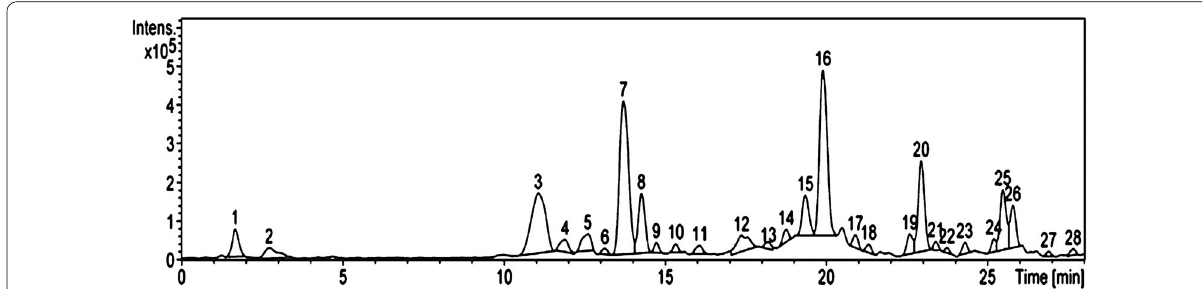
Fig. 1 Anthocyanin profile of blue tortilla obtained by means of